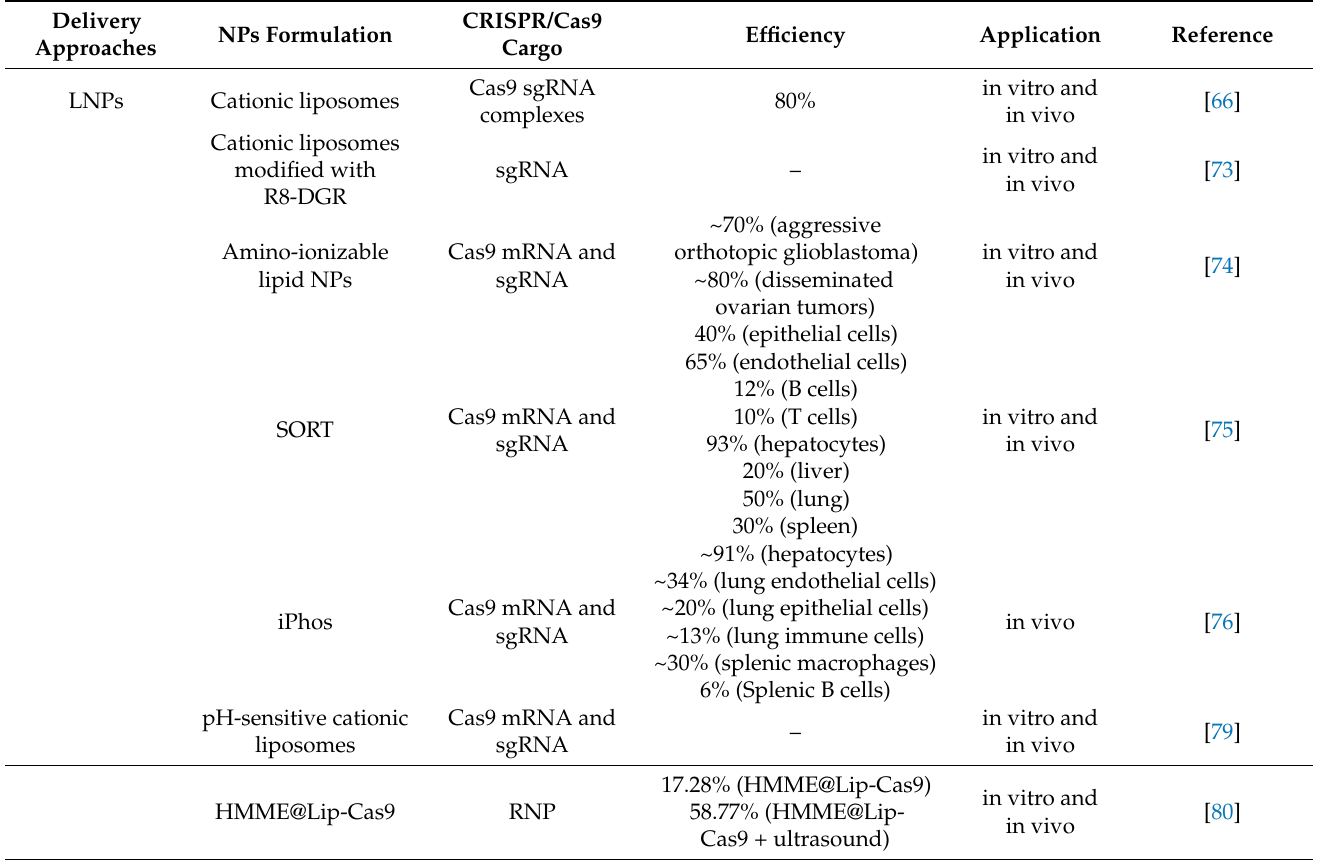
Table 1. NPs-based CRISPR/Cas9